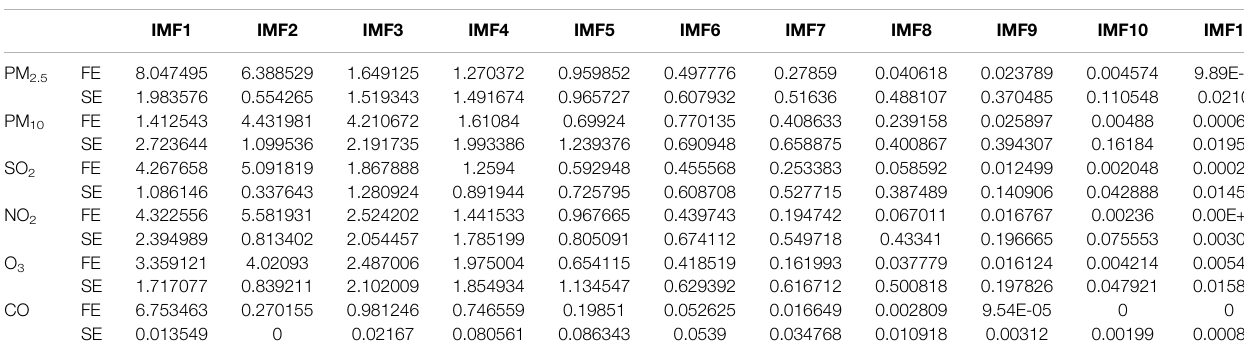
TABLE 2 | Sample and fuzzy entropy of